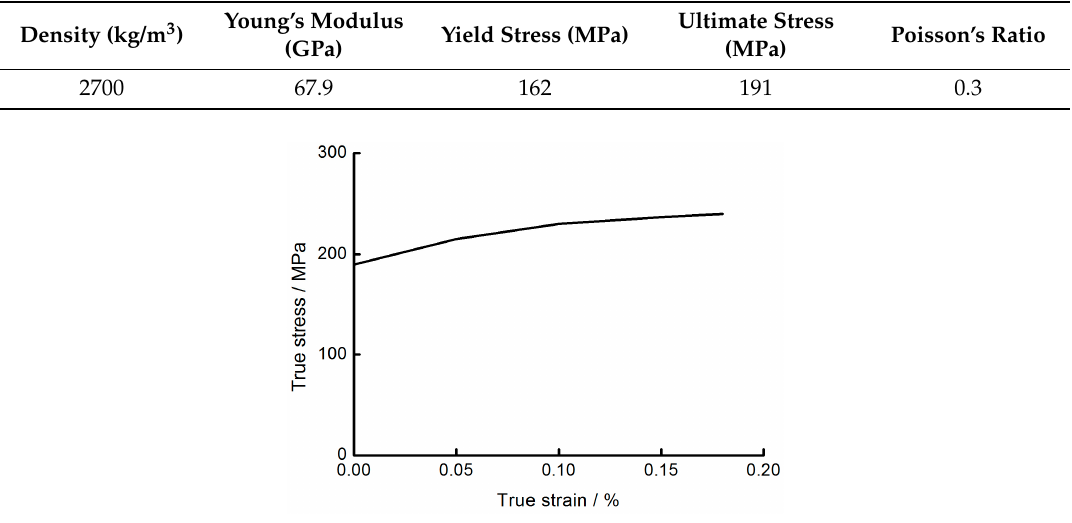
Table 1. Mechanical behaviors of AA6063 for the bionic structures.